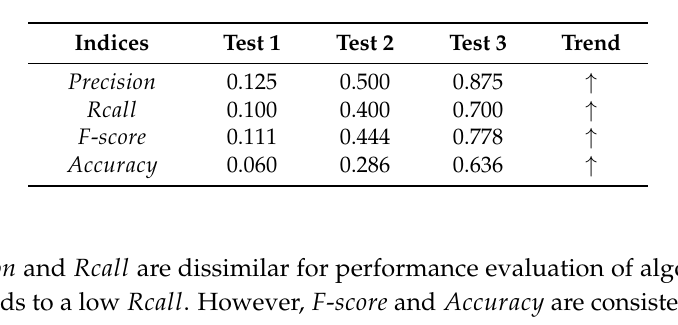
Figure 17. Example 2 for 𝑃𝑟𝑒𝑐𝑖𝑠𝑖𝑜𝑛 and 𝑅𝑐𝑎𝑙𝑙 , where 𝑃 (cid:3045) = 100 and 𝑃 (cid:3039) is variant: ( a ) Test 1, 𝑃 (cid:3039) =